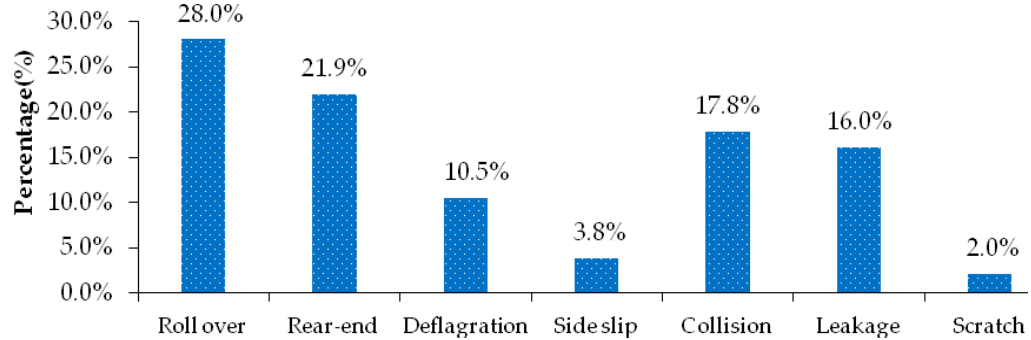
Figure 2. Distribution characteristics of types of hazardous materials transportation accidents.